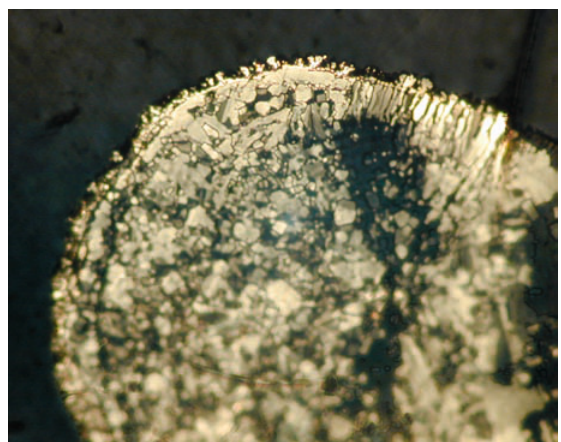
Figure 3. Organic spherules (pollen) in Romanite: the organic matter is substituted by feldspar, N+,